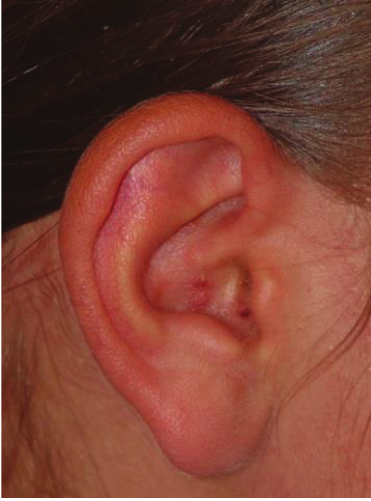
Figure 2: Crusted herpetic vesicles on the right ear